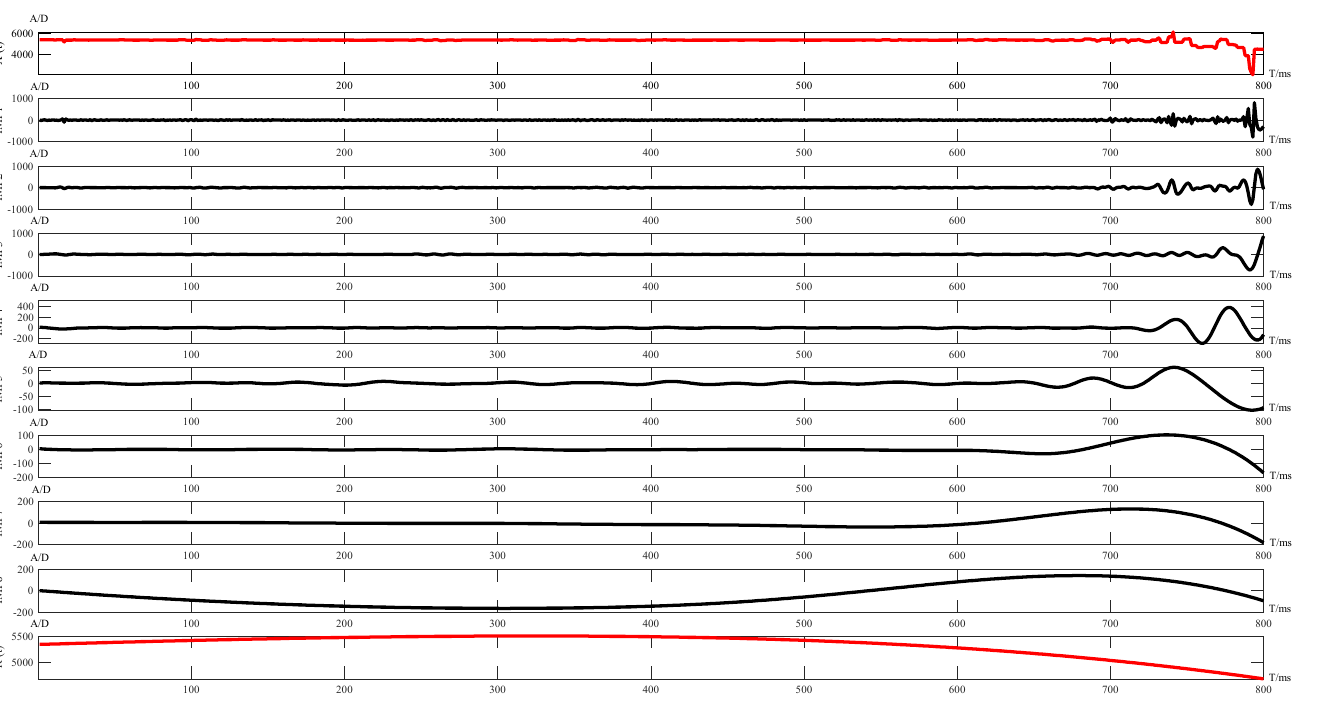
Figure 15. The rendering of the EEMD fi lter. As shown in Figure 16, the elimination of ji tt er in the horizontal part of the EEMD algorithm was largely not di ff erent from the e ff ect of the fi rst-order Kalman fi lter, and the processing of spiky data by the EEMD algorithm was much smoother, with almost no